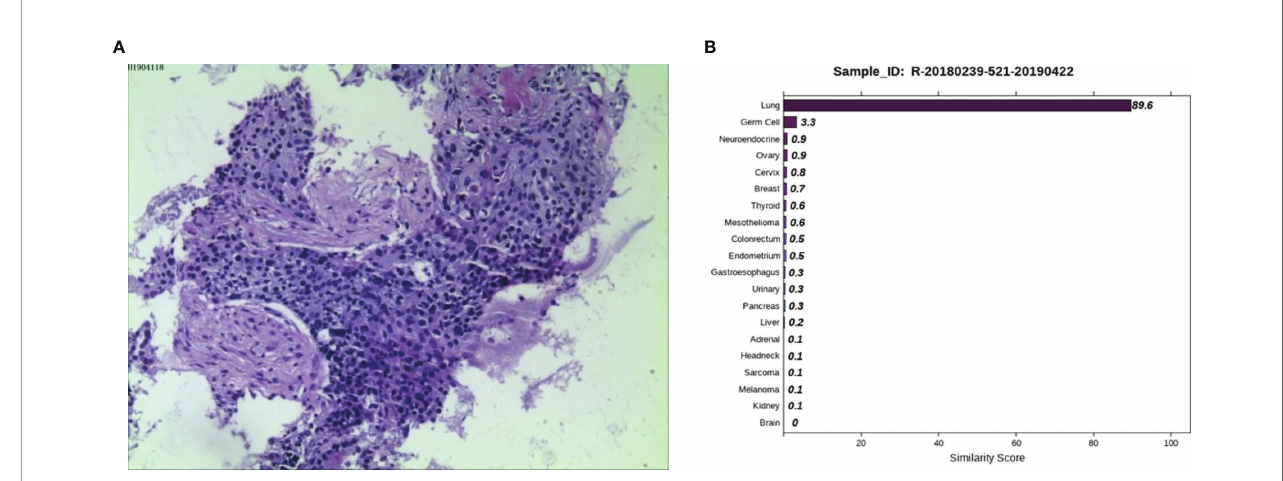
FIGURE 1 | Pathological and 90-gene expression assay results of case 1. (A) The pathological diagnosis of the resected specimens was squamous cell carcinoma. Immunohistochemistry staining: P40 (-), Ki67 (90%+), TTF1 (-), CK7 (-), P16 (-). (B) The 90-gene expression assay showed that the similarity score of the right lung mass coming from the lung tissue is